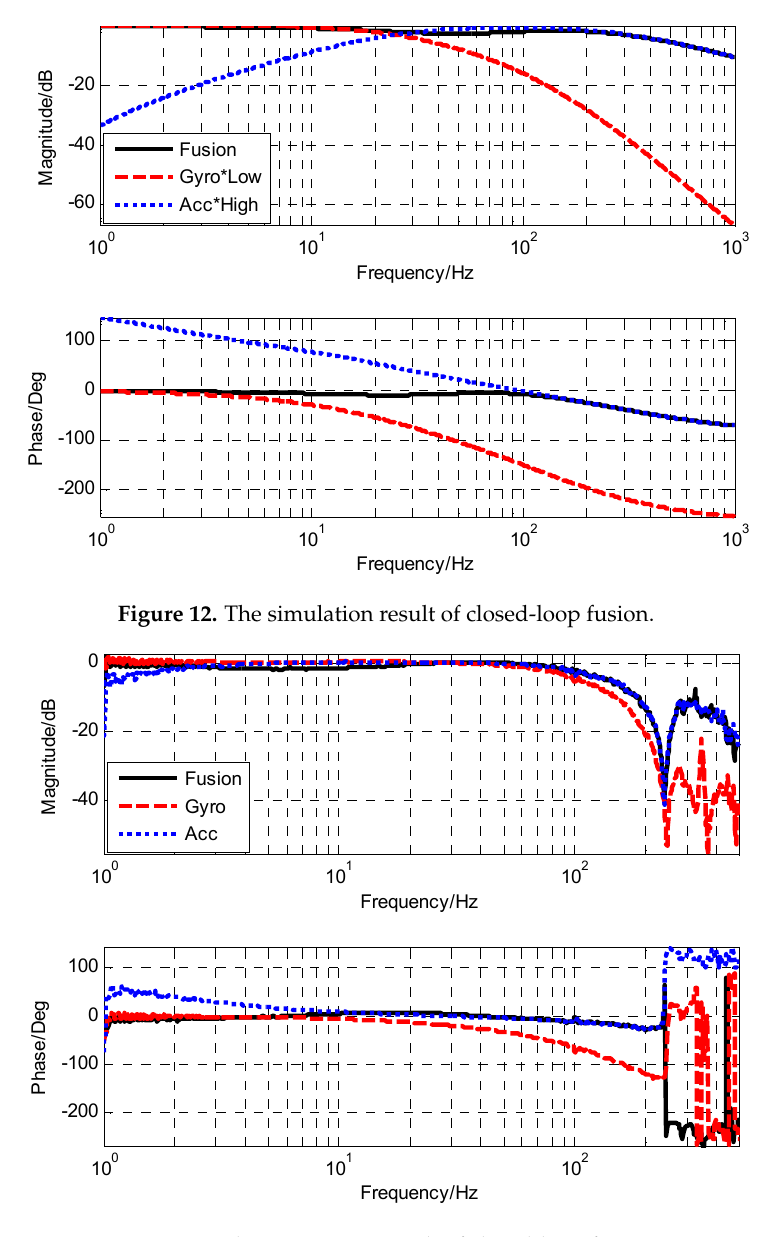
Figure 13. The experiment result of closed-loop fusion.